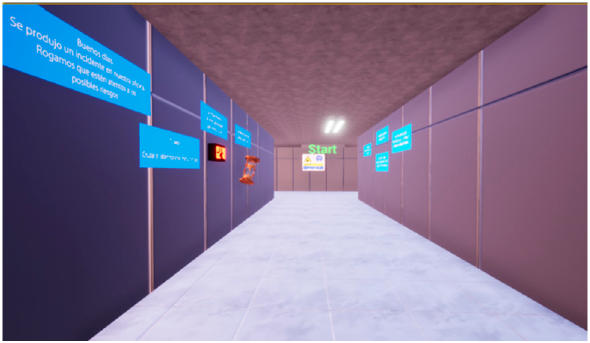
Figure 4. Pre-experiment training room.